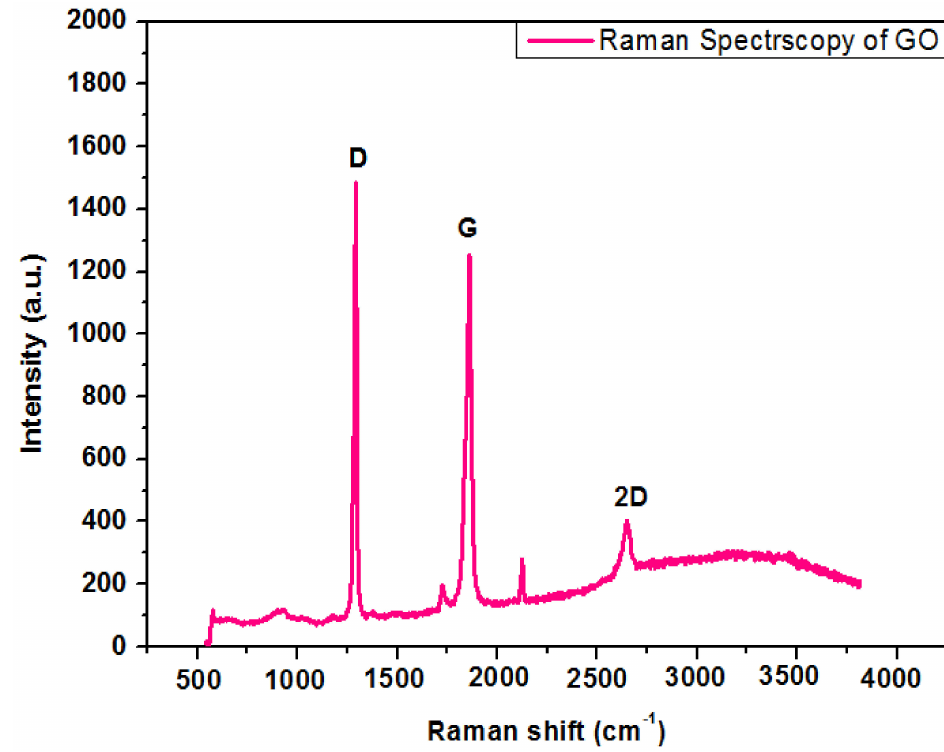
Figure 5. Raman spectroscopy of graphene oxide.